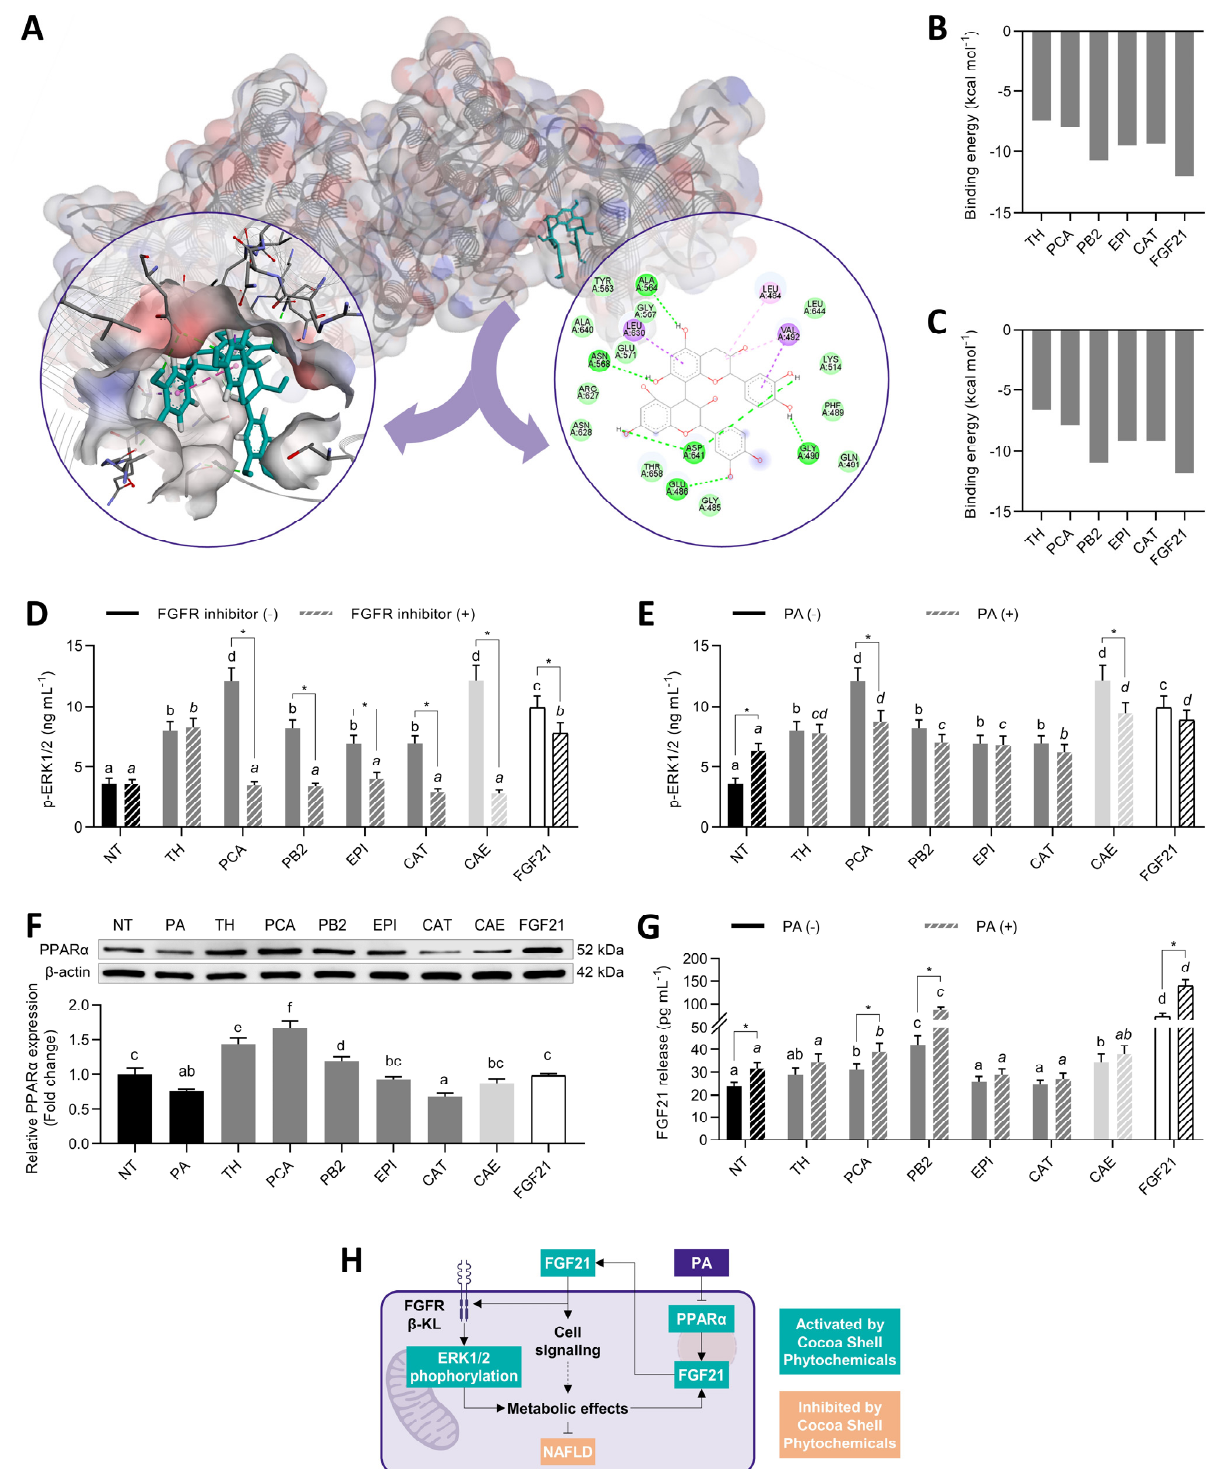
Figure 2. Activating effects of pure phytochemicals from the cocoa shell (50 µ mol L − 1 ), aqueous extract (CAE, 100 µ g mL − 1 ), and FGF21 (20 nmol L − 1 ), in the presence of PD173074 (FGFR1 inhibitor, 50 nmol L − 1 ) or palmitic acid (PA, 500 µ mol L − 1 ), on FGF21 signaling in HepG2 human hepatocytes. Phytochemicals interacted in silico with the subunits of the FGF21R ( A ), exhibiting different binding energies for FGFR1 ( B ) and β -klotho ( C ), leading to increases in ERK1/2 phosphorylation ( D , E ). Simultaneously, HepG2 exhibited increased PPAR α protein expression ( F ) and FGF21 release ( G ). Integrative diagram illustrating the effects of the phytochemicals from the cocoa shell on